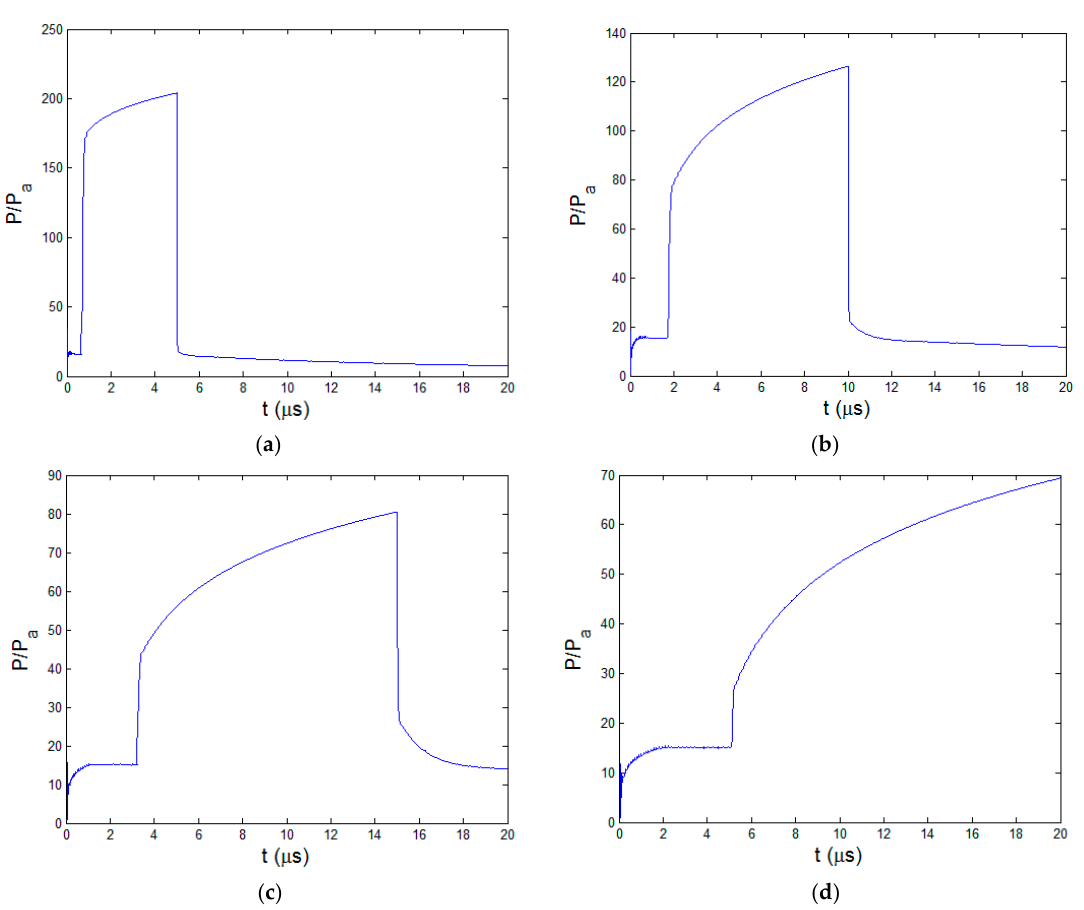
x ( a ) 5 μ s; ( b ) 10 μ s; ( c ) 15 μ s; ( d ) 20 μ s. Figure 12. Pressure fields of different pulse lengths at x µ s; ( b ) 10 µ s; ( c ) 15 µ s; ( d ) 20 µ b b ( a ) 5